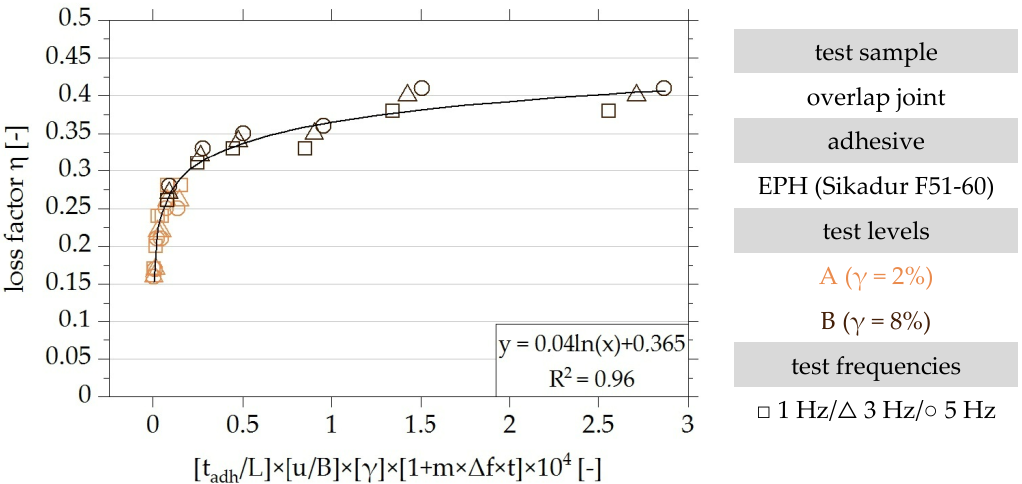
Figure 17. Dimensionless visualisation of the results of the experimental investigation of overlap joints made with the EPH adhesive and their approximation by a logarithmic regression function, taking into account the dimensionless parameters Π 2 , Π 3 , Π 4 and Π 5 based on [22].